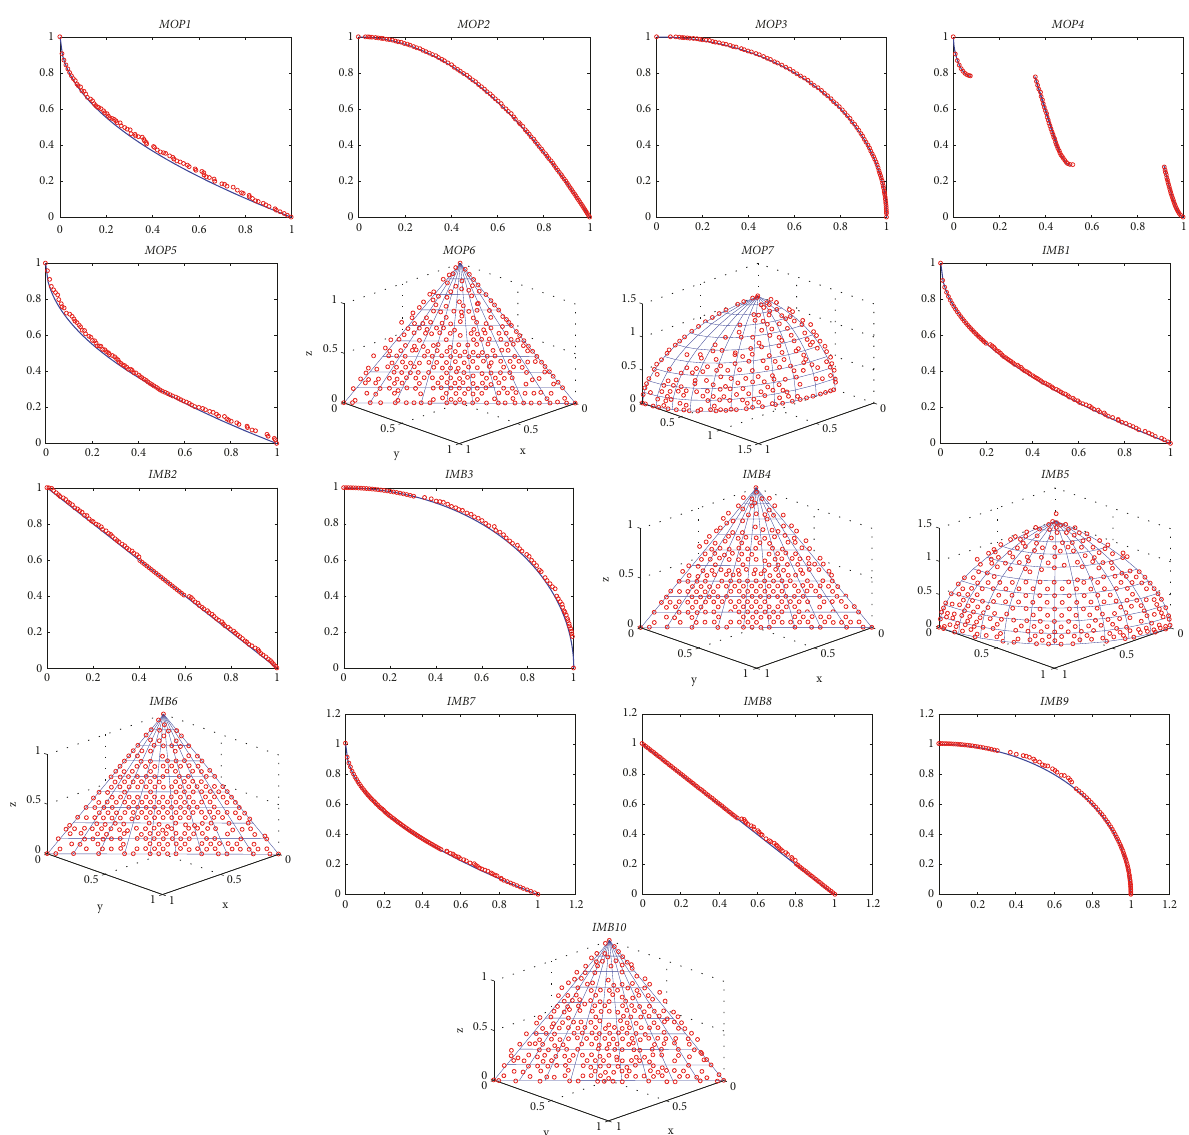
Figure 2: The nondominated solution sets on MOP1 - MOP7 and IMB1 - IMB10 .